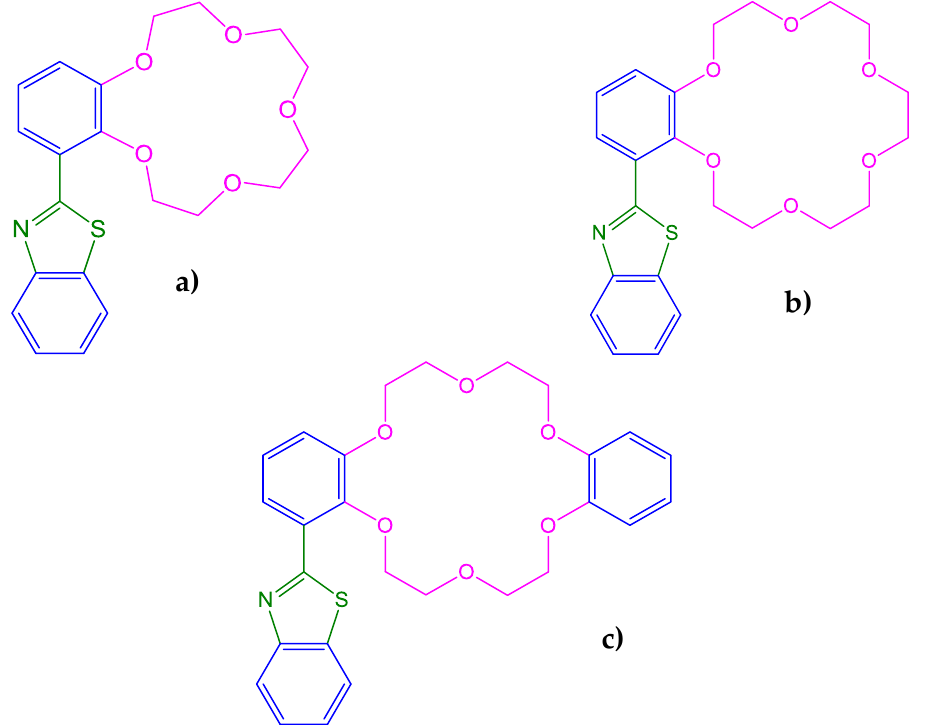
Figure 12. Structures of benzothiazole crown ethers ( 16a – c ).